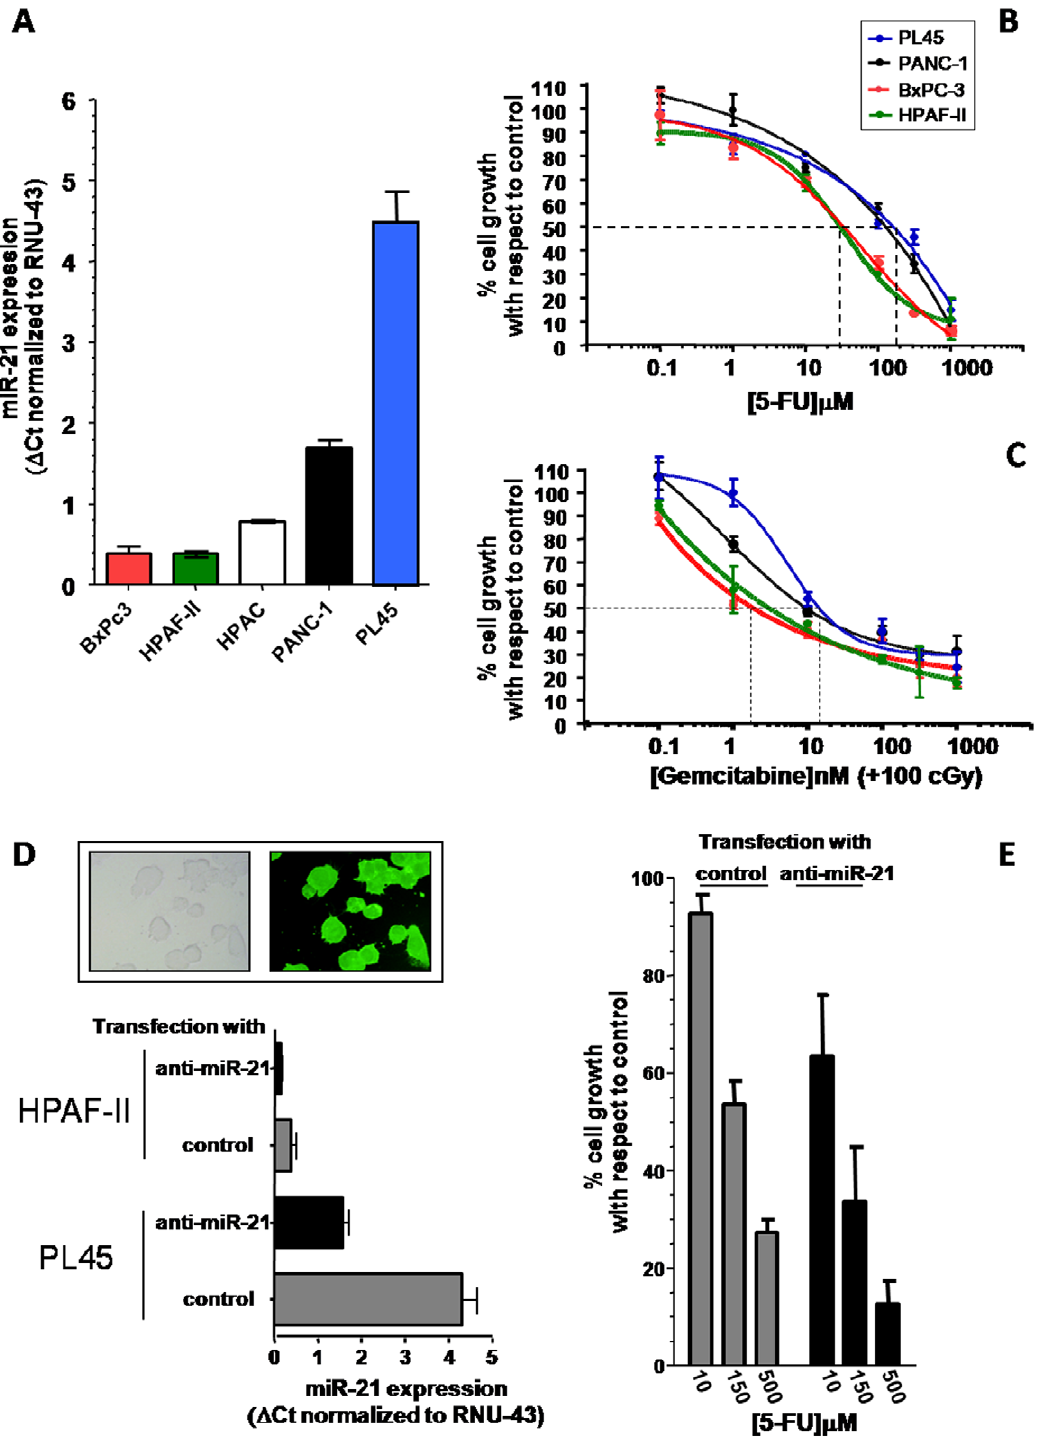
Figure 3. In vitro studies validating the role of miR-21 in PDAC chemosensitivity. (A) MiR-21 expression in 5 PDAC cell lines. Expression was determined by quantitative PCR, using the delta Ct method with RNU-43 as reference and the values are in a.u.. (B–C) Representative curves of growth inhibitory effects of 5-FU (B) and gemcitabine plus radiotherapy (C), 48-hour drug exposure. (D). Cells were seeded at 10 4 /well and the anti- proliferative effects were evaluated using the SRB assay, as described in the methods. The mean IC 50 values for 5-FU (48 h continuous exposure) were as follows: 36.3 m M (BxPC-3), 30.9 m M (HPAF-II), 138.4 m M (PANC-1) and 174.2 m M (PL45); while the IC50 values for gemcitabine (in cells pre-treated with 100 cGray) were 2.1 nM (BxPC-3), 3.4 nM (HPAF-II), 10.2 nM (PANC-1) and 11.4 nM (PL45). (D) MiR-21 expression in HPAF-II and PL45 cells transfected with negative controls or with anti-miR-21 oligos. Transfection efficiency was evaluated by fluorescence microscopy as shown in the pictures in the upper panel, original magnification, x40 (E) Modulation of 5-FU antiproliferative effects in PL45 cells transfected with anti-miR-21 in comparison with control transfected cells. Columns , mean values obtained from three independent experiments; bars , SE, dashed lines , concentrations corresponding to 50% inhibition of cell growth with respect to control, i.e. IC 50 values. doi:10.1371/journal.pone.0010630.g003 PLoS ONE |